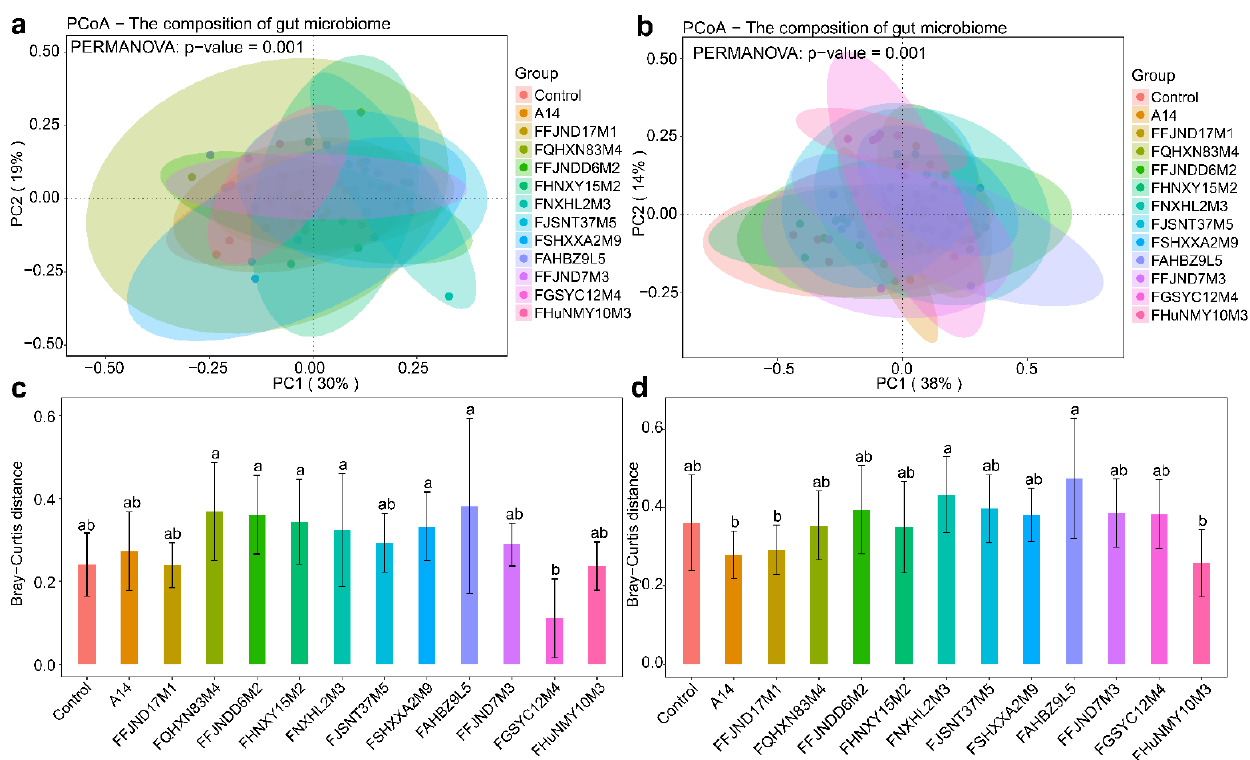
Figure 8. Beta diversity indexes (Bray–Curtis) of gut microbiota in different mice group at different time points (( a , c ): 21 days, ( b , d ): 28 days). Different lowercase letters mean that there is a statistically significant difference between 13 groups at a probability level of p < 0.05.